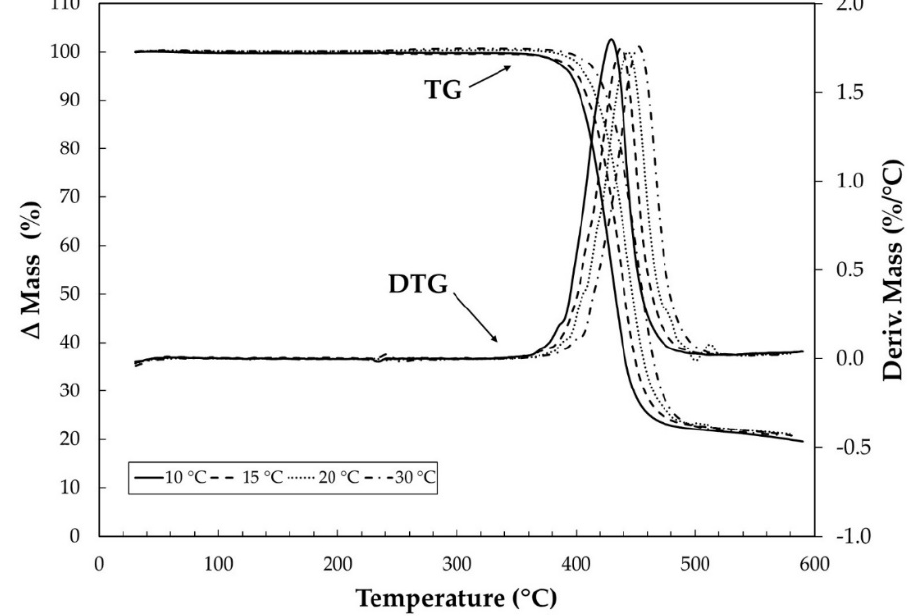
Figure 8. TG/DTG curves of virgin PET with heating rates of 10, 15, 20, and 30 °C·min − 1 under carbonic gas with flow of 100 mL min − 1 in α -alumina crucible. The temperature intervals used for the kinetic evaluation are shown in Table 1, while the mean values of activation energy and the coefficients of variation are shown in Table 2. The dependence of activation energy on the degree of conversion ( α ) for the samples is shown in Figure 9. The variation observed in the activation energy under purge gases of carbonic gas and synthetic air suggests that the process is kinetically variable with all methods used. The evaluation from the Capela/Ribeiro and Ozawa methods indicates that the degradation kinetics is governed by unique processes at the initial and final stages, while the Friedmann method had greater variations throughout the range of conversion degree for virgin PET samples and for samples after aging of 500